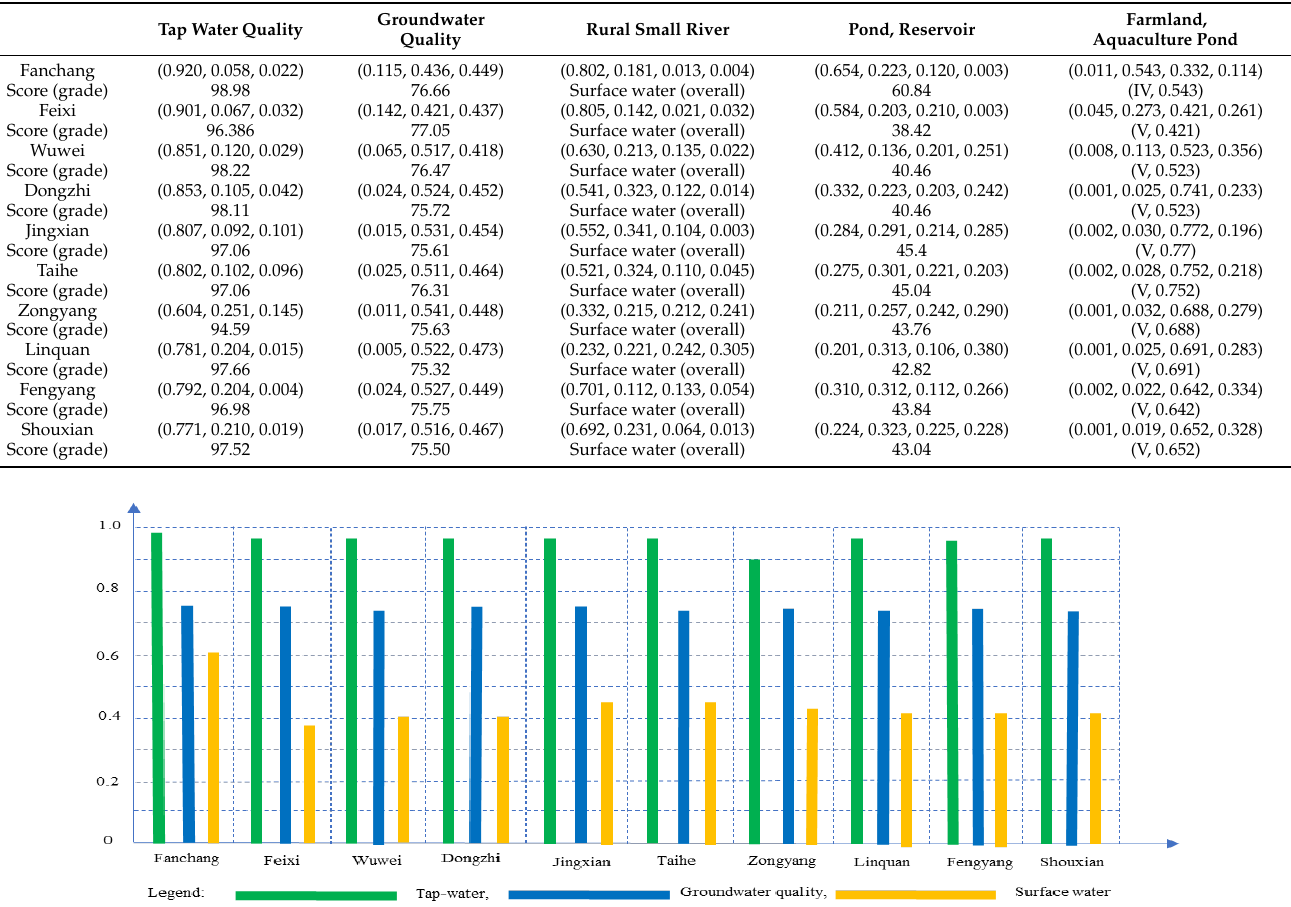
Figure 4. Quality of rural tap water, groundwater and surface water in 10 sample counties.